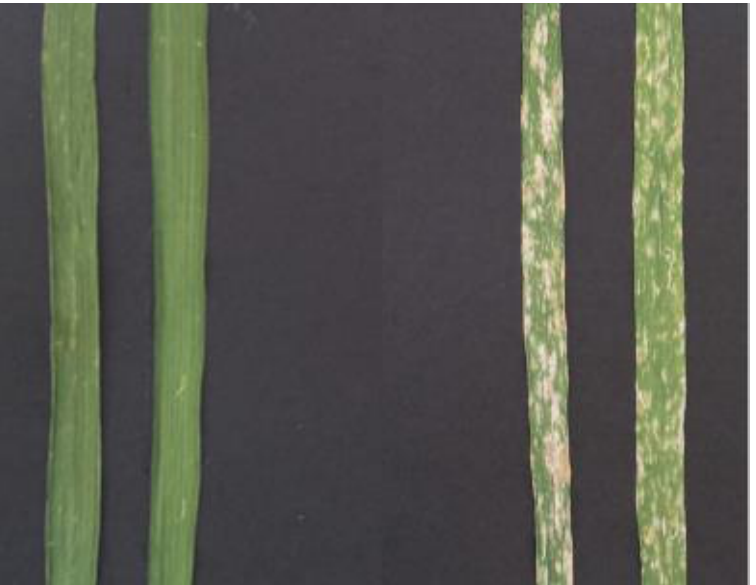
Figure 2. Phenotypes of powdery mildew resistant durum backcross inbred line 5BIL-42 (on the left ) and of the durum recurrent parental line Latino (on the right ) 12 days post-inoculation with Bgt race O2.